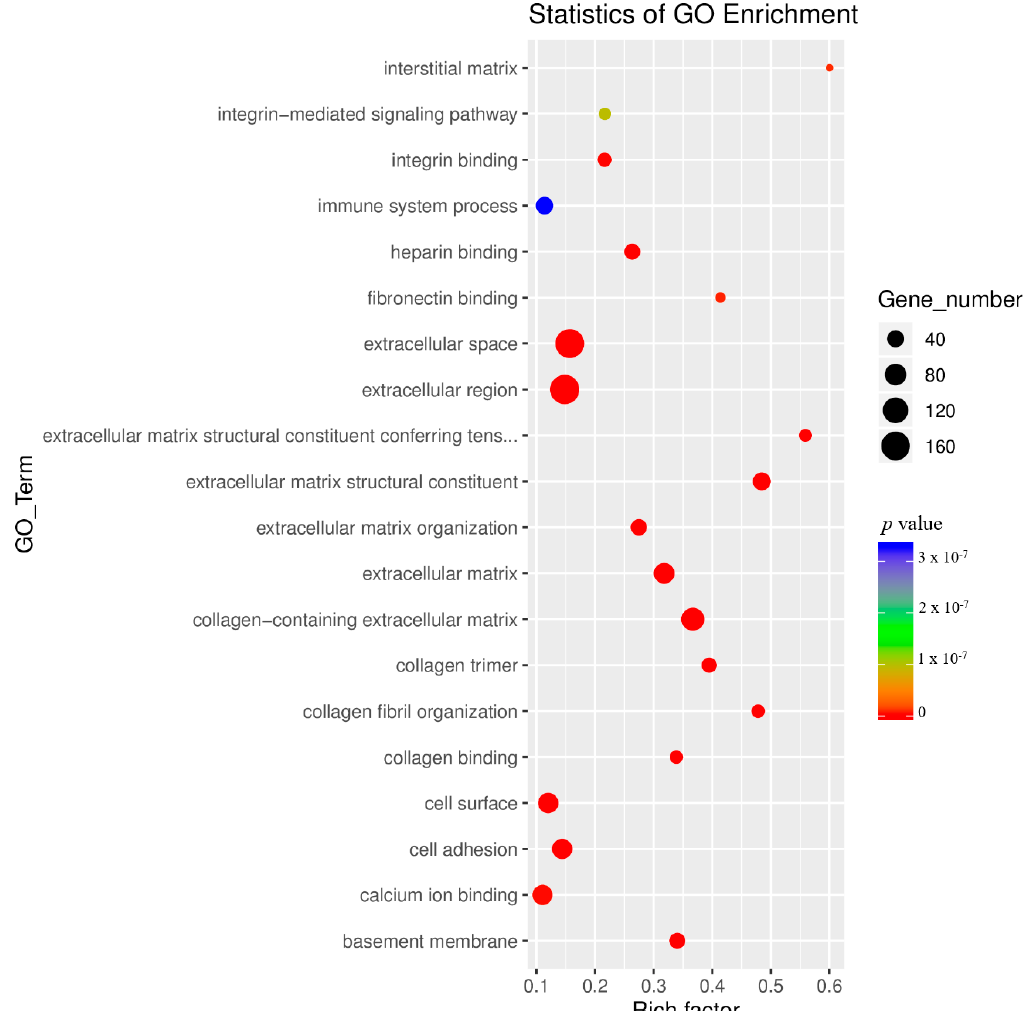
Figure 7. GO enrichment analysis conducted on GO terms annotated to significant differentially expressed (DE) genes across all GO categories. Rich factor is assessed by the ratio of DE genes annotated to a specific GO term to the total number of genes annotated to that GO term; a greater rich factor value indicates a greater degree of GO term enrichment.